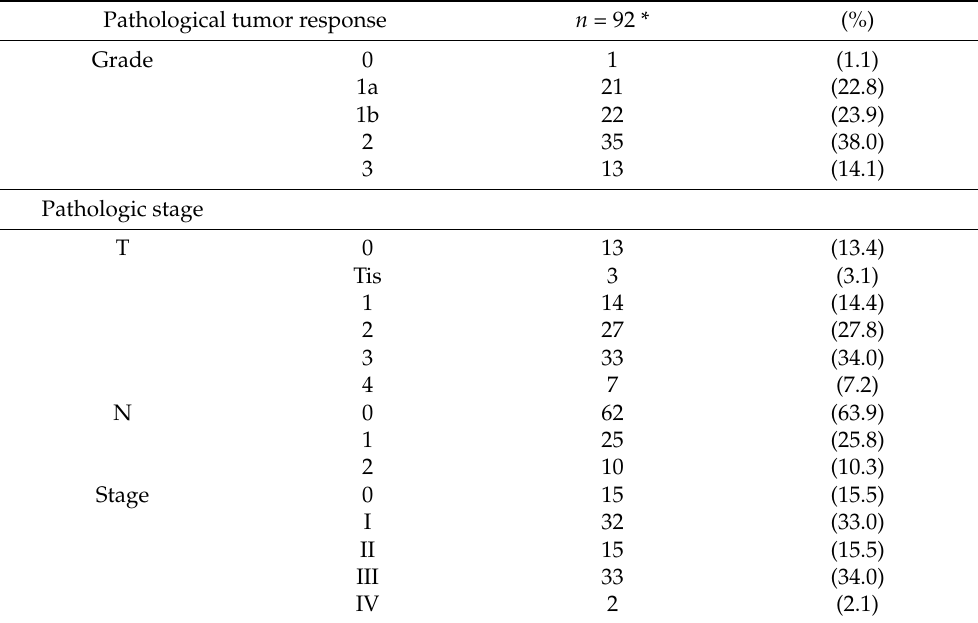
Table 3. Pathological responses to neoadjuvant therapy.